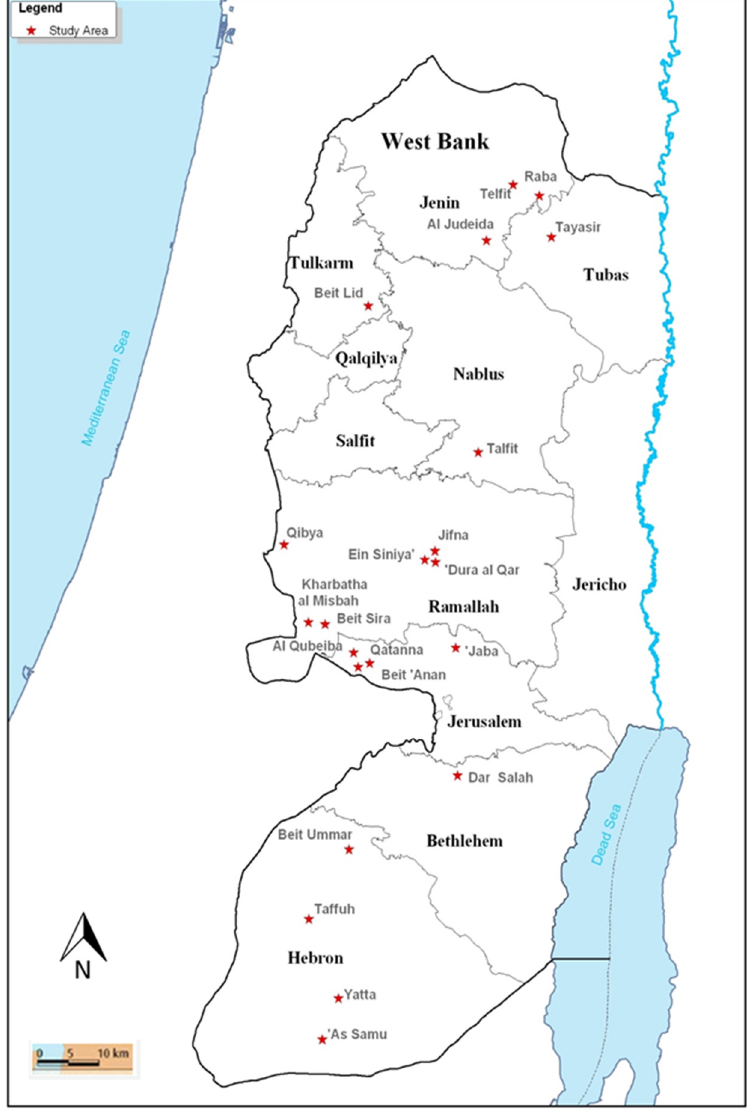
Figure 4. Study area in eight governorates of the West Bank.